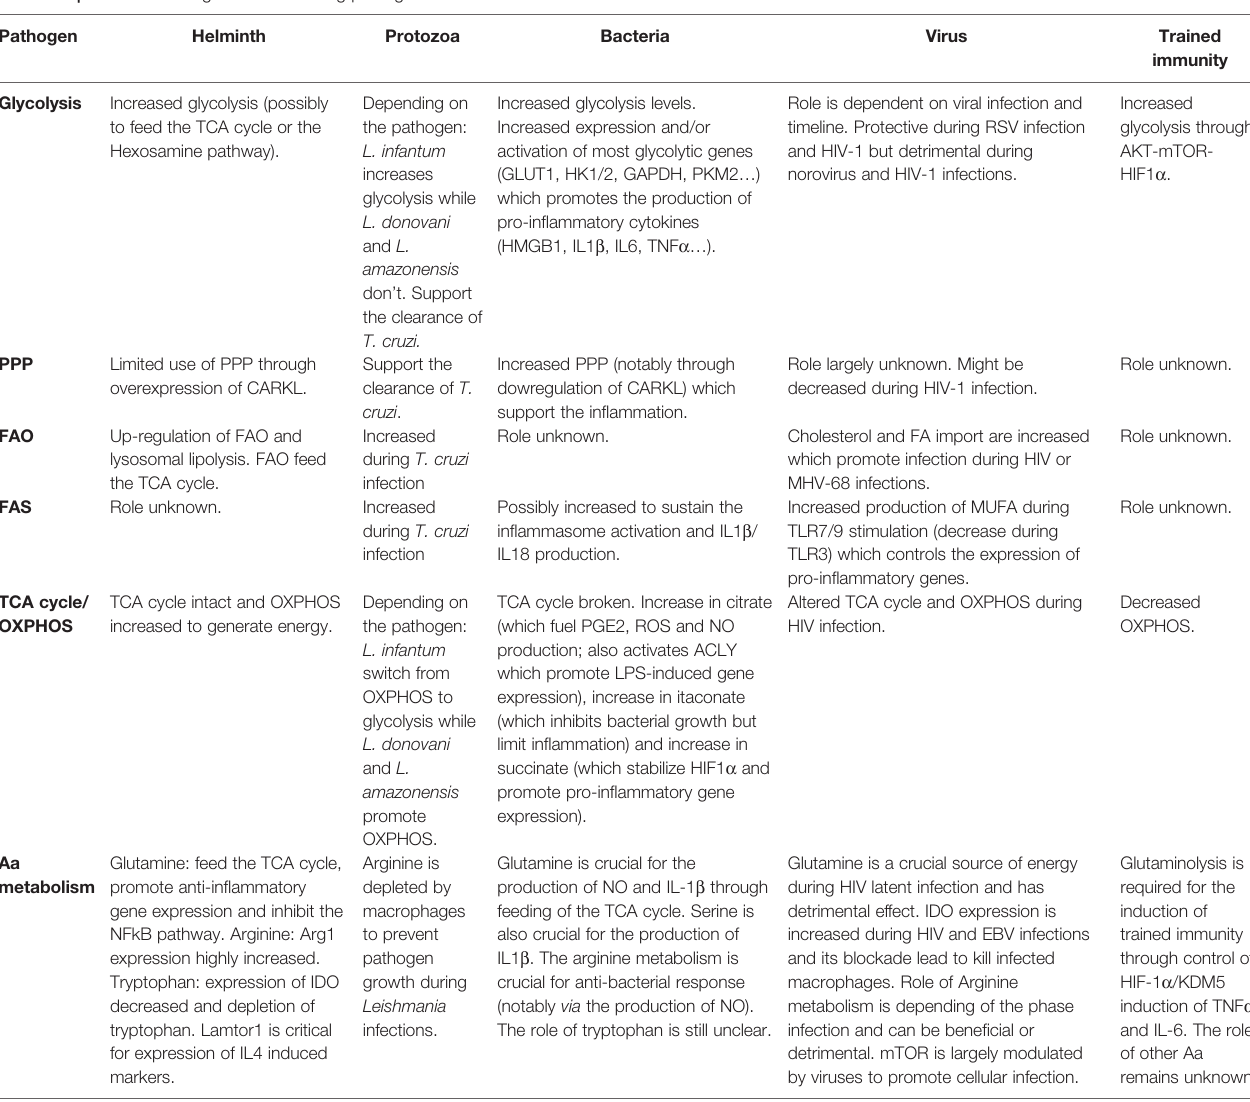
TABLE 1 | Metabolic changes induced during pathogen